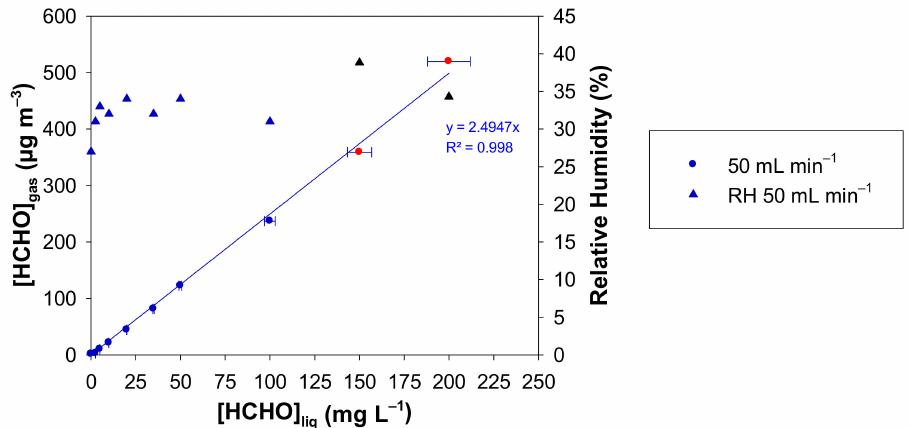
Figure 4. Concentration of gaseous formaldehyde ([HCHO] gas ) and relative humidity measured with the formaldehyde analyser ( µ F1, Chromatotec, Val-de-Virv é e, France) vs. the liquid formaldehyde concentration with F gas = 50 mL min − 1 , T = 10.7 ◦ C, L = 7 cm, a photomultiplier gain set at 50% and [HCHO] liq = 0–200 mg L − 1 . The horizontal error bars correspond to the uncertainties calculated from the preparation of the liquid formaldehyde solution. The vertical error bars correspond to two times the standard deviation, but they are too small to be visible. Red circles and black triangles mean that the generated gaseous formaldehyde mixture has been diluted prior to analysis, so a correction has been applied to obtain the real values of [HCHO] gas and